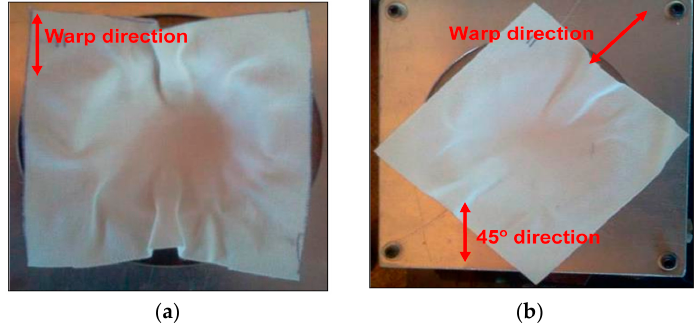
Figure 12. Formation of wrinkles in a dry bamboo fabric for ( a ) warpand; ( b ) 45° directions.